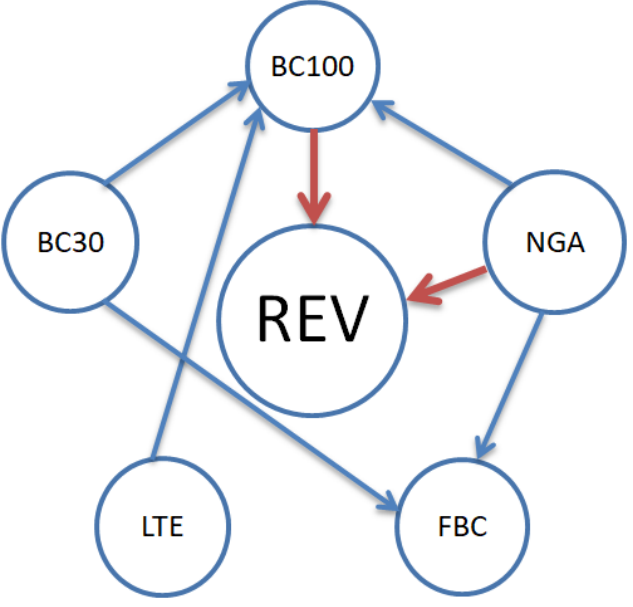
Figure 5. Pairwise Granger causality results .